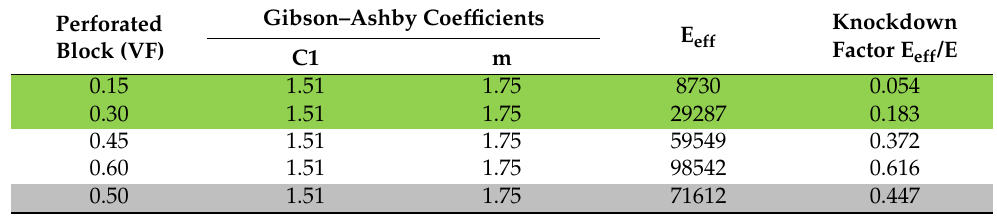
Table 5. Scaling relation using the Gibson–Ashby model for perforated block support.